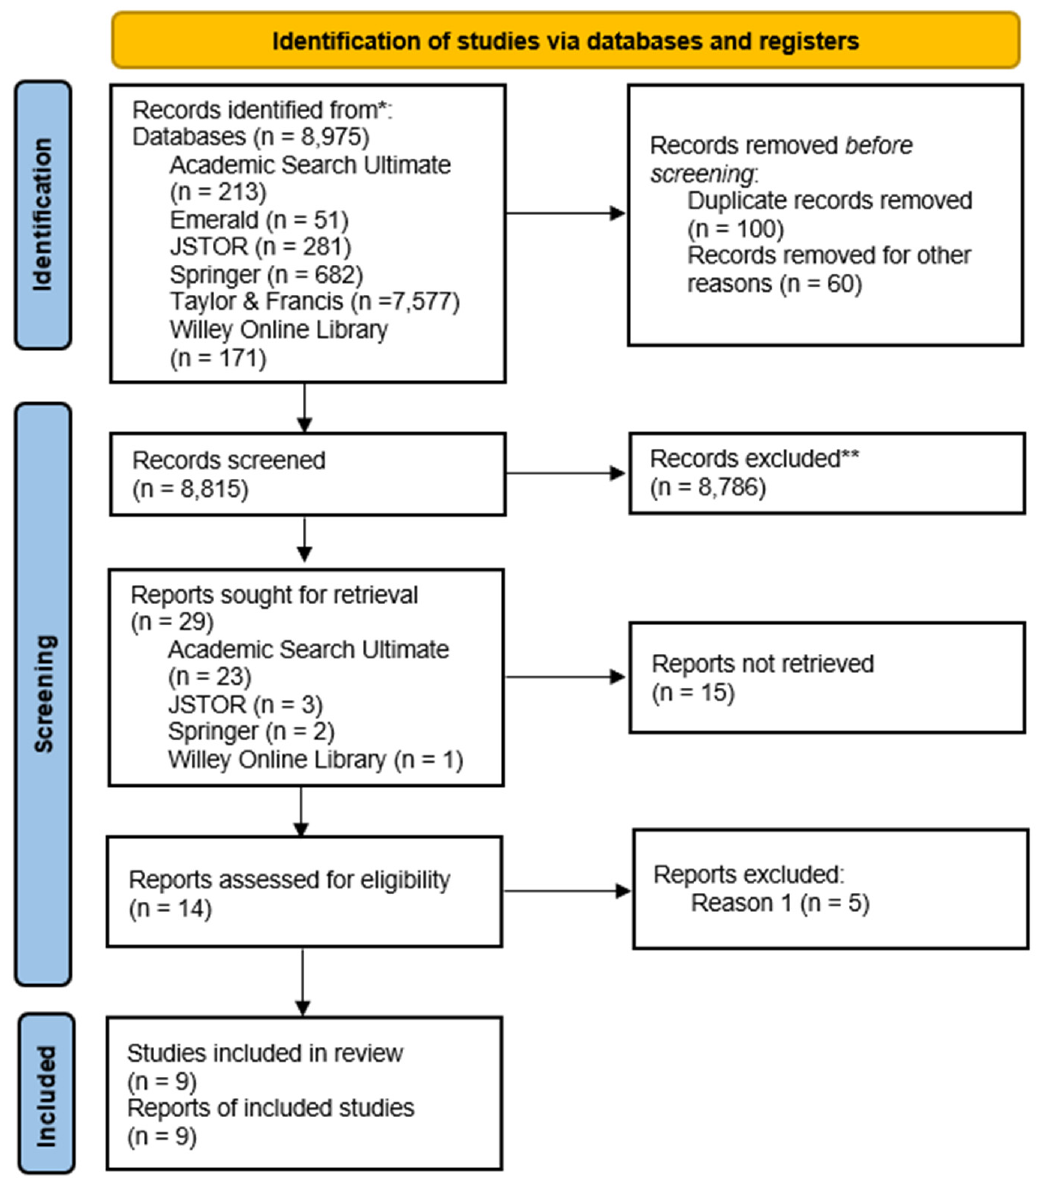
Figure 1. The PRISMA chart for screening, article selection, and evaluation. Note: * Consider, if feasible to do so, reporting the number of records identified from each database or register searched (rather than the total number across all databases/registers). ** If automation tools were used, indicate how many records were excluded by a human and how many were excluded by automation tools.